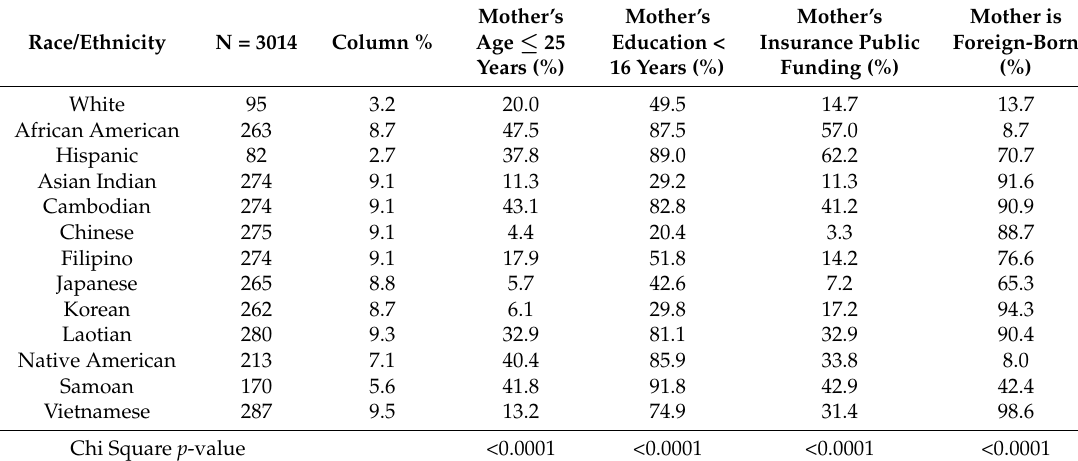
Table 1. Demographic characteristics of prenatal screening program enrollees in 13 race/ethnic groups, San Diego, Orange and Imperial counties (N = 3014)